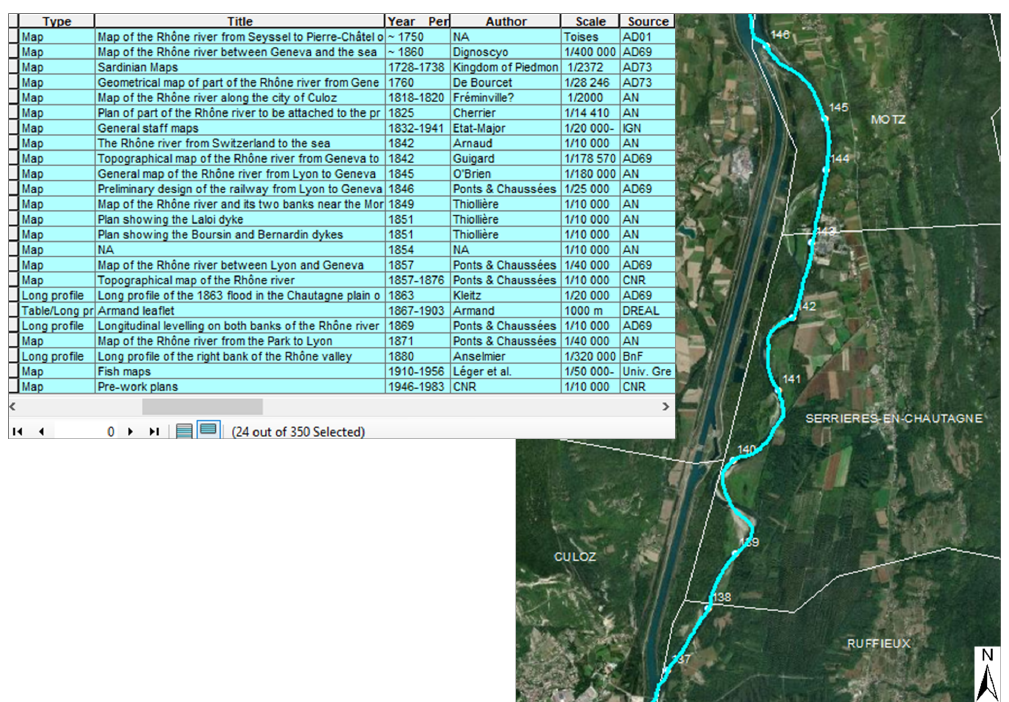
Figure 9. GIS layer of the longitudinal coverage of data collected in this study. Example of the 24 available data items on the Chautagne river reach (KP − 146 to − 137). Basemap: